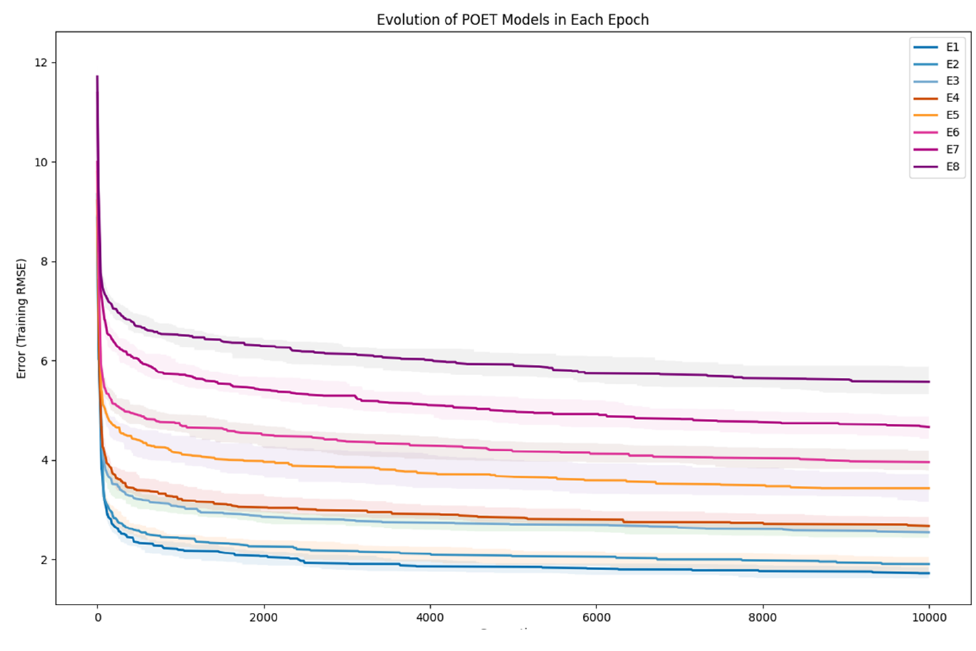
Figure 5 Evolution of the POET models over generations for eight epochs of the POET experiment. The fitness metric is Training RMSE (RMSE over epoch data), and therefore, lower values indicate more accurate measurements. Full-size DOI: